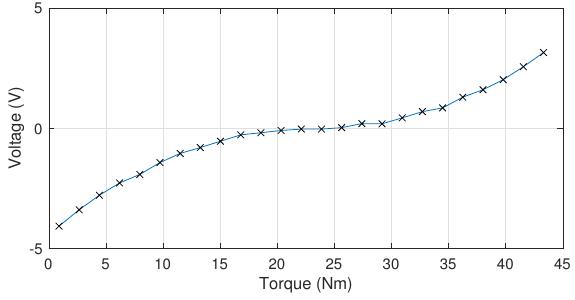
Figure 9. Torquemetercalibration curve: Voltage (V)/Torque